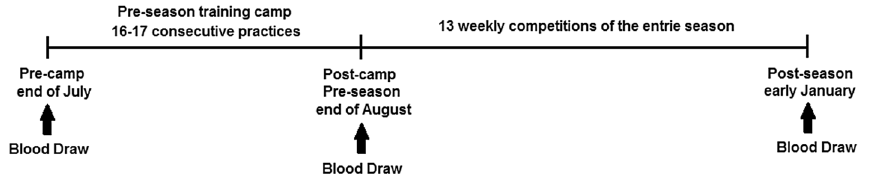
Figure 1. The time-point of the blood draws throughout the entire football